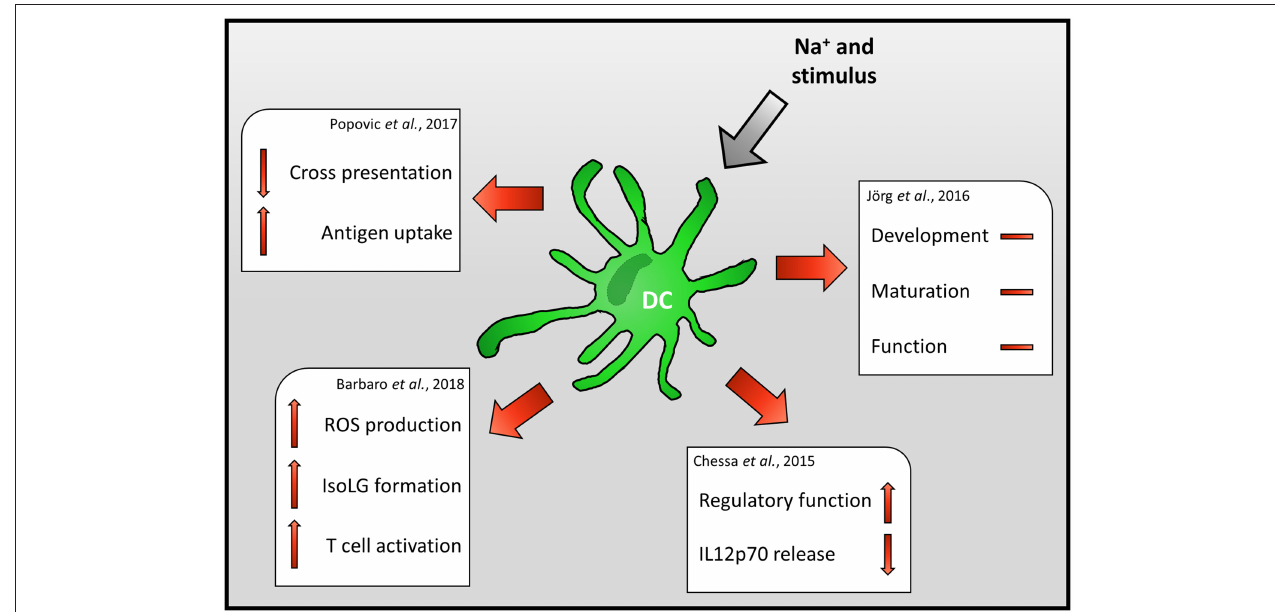
FIGURE 2 | Impact of Na + on DC